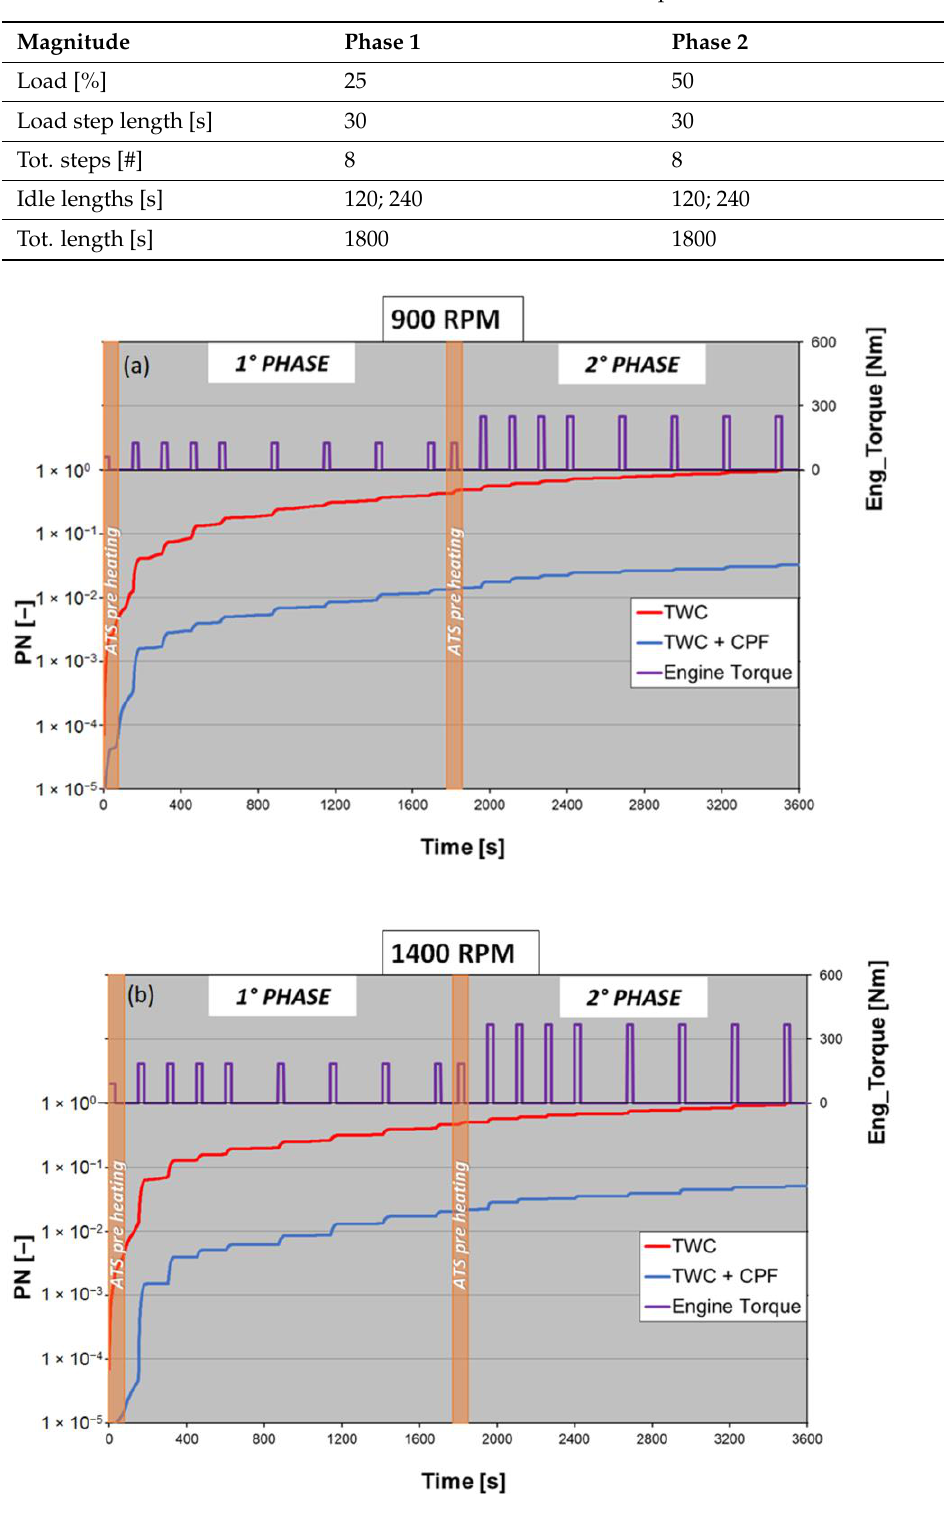
Figure 9. The cumulative profile of the mean PN emissions over step load cycle, with and without the CPF; dimensionless values. At 900 rpm ( a ) and at 1400 rpm ( b ). In Figure 9, a logarithmic scale was used on the y-axis. For both test modes, the CPF reduced the PN by more than one order of magnitude during the duration of the tests. The abatement was higher for the 900 rpm tests.